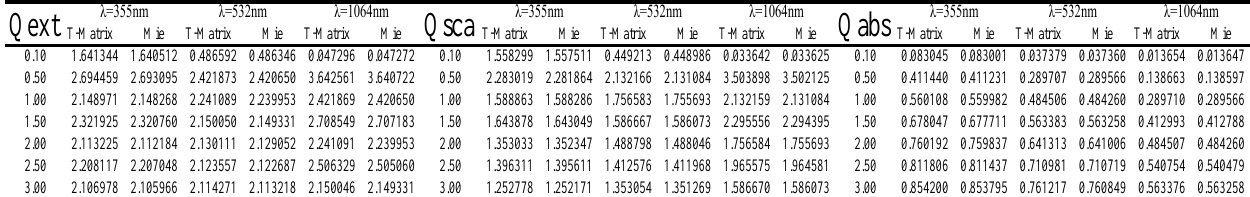
Table 1. Calculation results of extinction, scattering and absorption efficiency factors of spherical particles using T-matrix method and Lorenz-Mie theory varying with particle size at different wavelengths In Table 1, the extinction efficiency factors, scattering